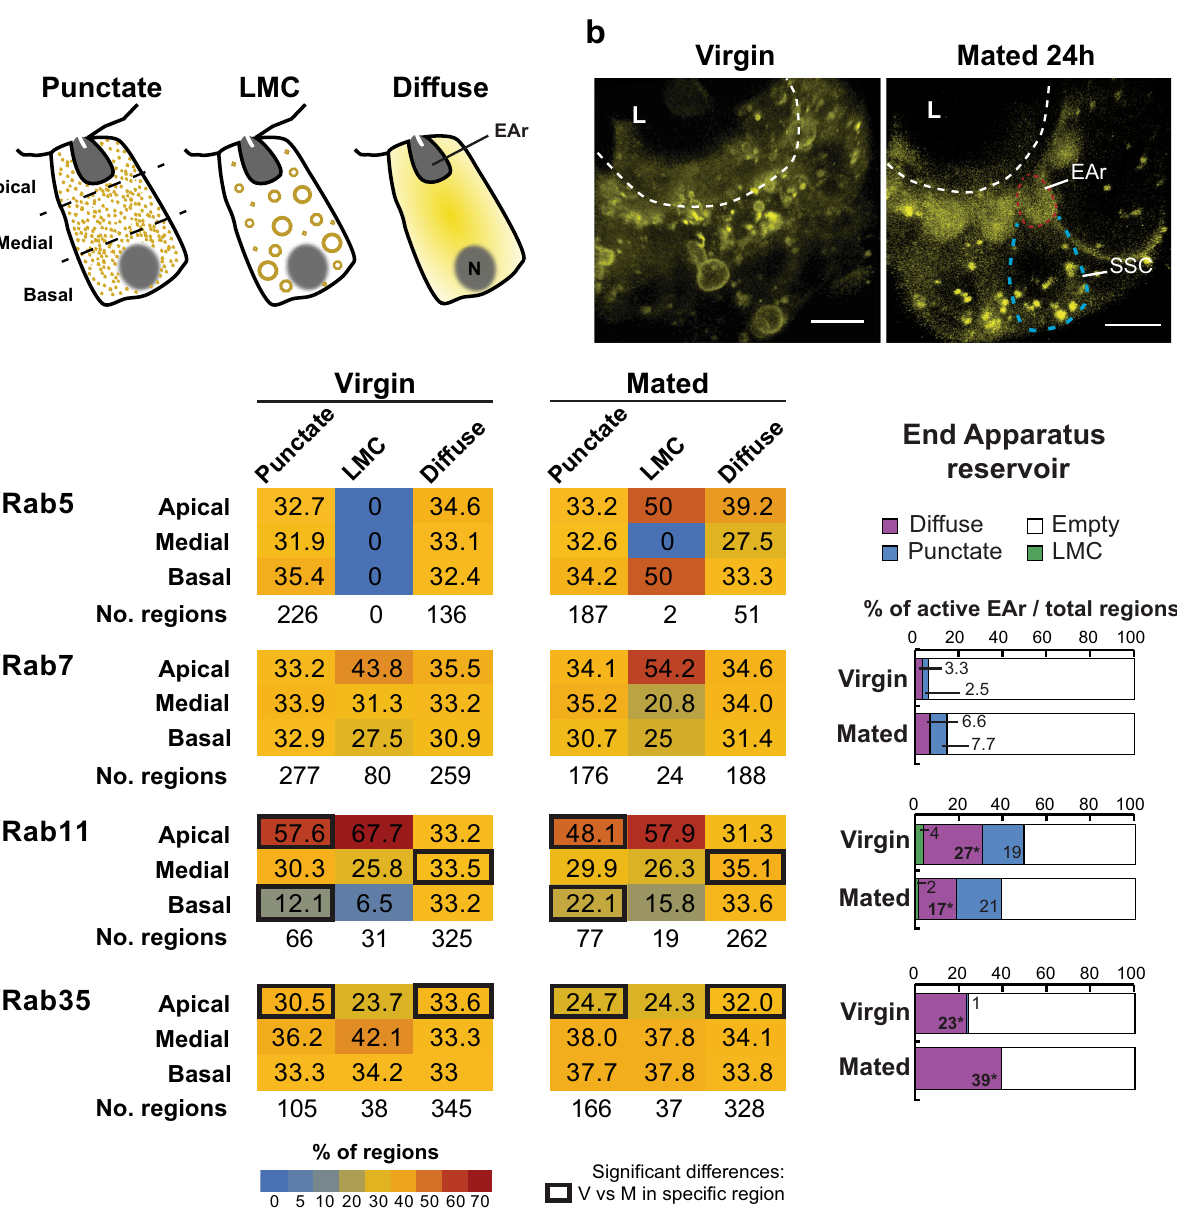
Fig. 2 The subcellular localization of Rab GTPases in the SSC is regulated by mating. Flies that express endogenous YFP-tagged Rabs ( YRab ; YRab5 , YRab7 , YRab11 , and YRab35 ) were used to visualize expression and determine subcellular localization of Rabs in the SSC. a Schematic depicting the type of localization patterns of YRabs in the SSC based on Dunst et al. 26 (punctate, large membranal compartment LMC or diffuse) within the apical, medial, basal subcellular regions of the SSC or in the End Apparatus reservoir (EAr); N = nuclei. b Representative images that show YRab35 in unmated and mated SSC at 24 h post-mating. Red and blue broken lines depict the EAr at the apical region of the SSC, respectively; L- lumen; scale bar = 5 µ m. c Heatmap pro fi les showing the distribution of different YRabs in SSC of virgin and mated females at 24 h post-mating. The heatmap color code represents the percentage of YRabs expressed in each subcellular region (apical, medial, basal), for each of the three pools, in every radial sections of virgin and mated SSC (the number of regions in which a speci fi c YRabs was expressed is shown at the bottom of each YRab heatmap). The bars at the right side represent the percentage of active EAr (i.e. EAr that contain YRab) in SSC of virgin or mated females out of the total sections observed (note, YRab5 was never observed in the EAr). Signi fi cant differences between virgin and mated ( n = 15 – 30 spermathecae from 10 – 20 fl ies) were estimated by the Incident Risk Ratio (IRR), indicated by black squares that surround cells in the heatmap and * inside the bar graphs ( p < 0.05). See also Supplementary Fig.